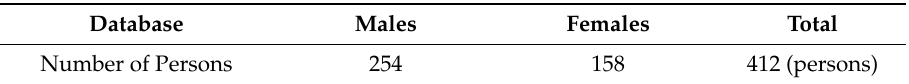
Table 2. Description of the collected database for our experiments (10 visible light images/person, and 10 thermal images/person).